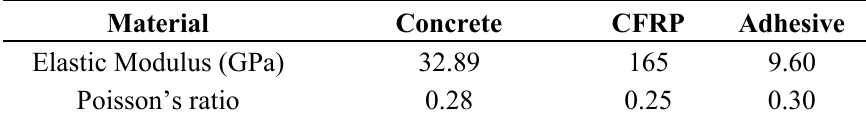
Table 3. The material properties for concrete, carbon fiber-reinforced polymer (CFRP) and adhesive.